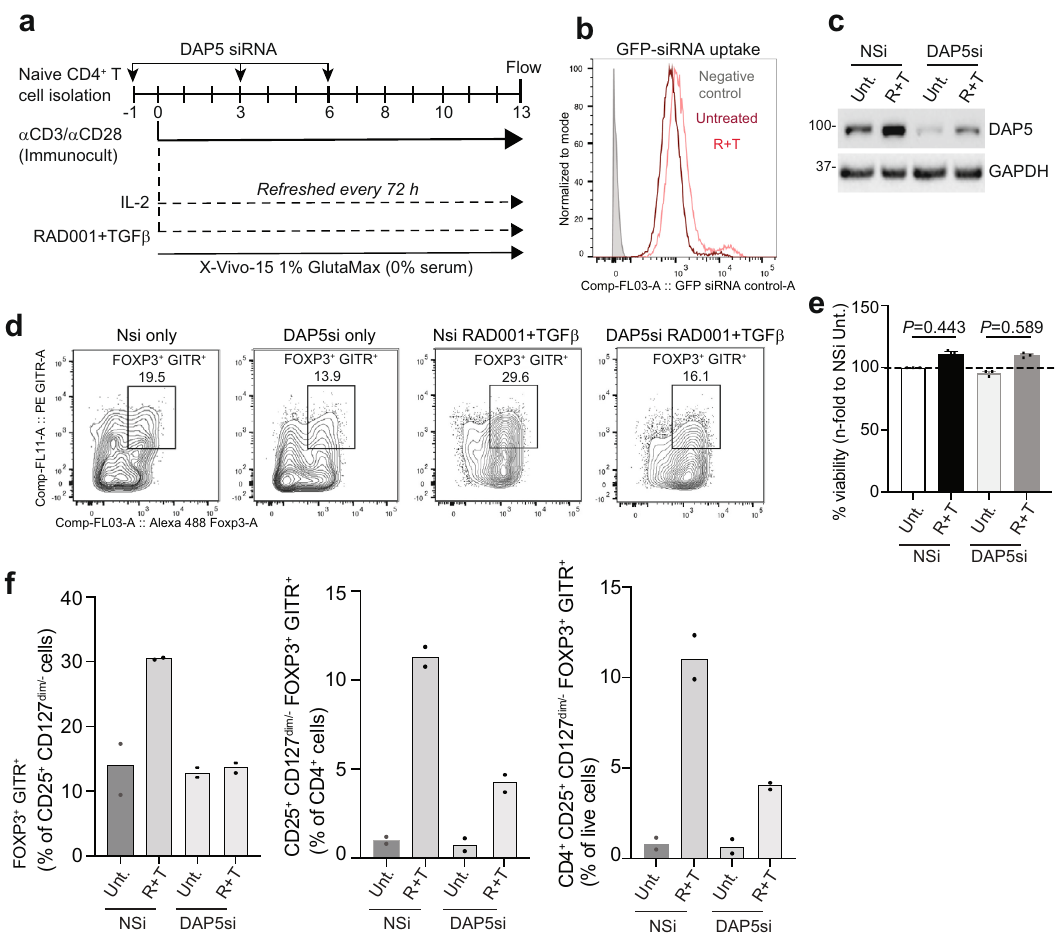
Fig. 8 DAP5 silencing blocks human naive CD4 + T cell differentiation into Treg cells. a Schema for silencing DAP5 in activated CD4 + T cells during differentiation. Human naive CD4 + T cells from two different donors were isolated from PBMCs as described in Fig. 2a legend. Cells were treated with 1 μ M of Accell SMARTpool siRNAs targeting DAP5 or a non-targeting siRNA pool in serum-free X-Vivo 15 media containing 1% GlutaMAX for 24 h, activated with IL-2 and differentiated with TGF-beta and RAD001 to induce iTreg cells and maintained as described in Methods. Accell SMARTpool siRNAs were re- added to culture medium on d 3 and 6 after activation and cells submitted to fl ow cytometry on d 13. Studies included a GFP-siRNA non-targeting